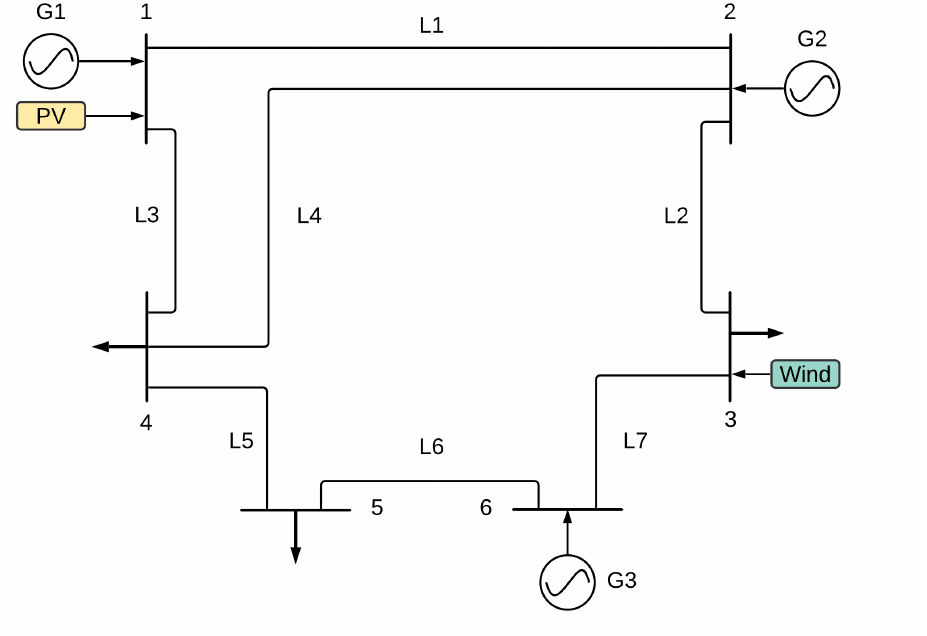
Figure 2. 6 bus test